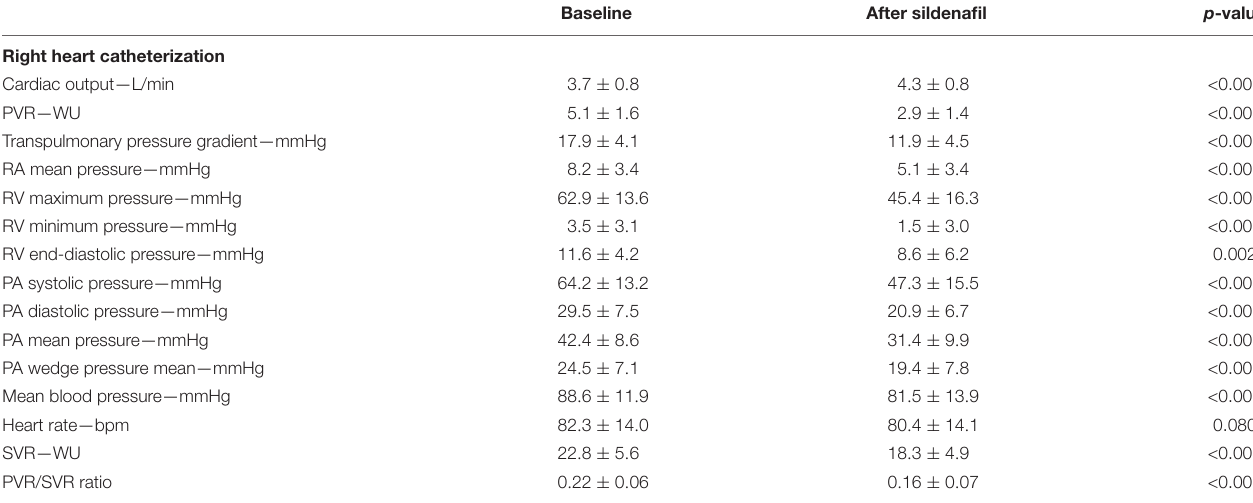
TABLE 2 | Effect of sildenafil on hemodynamic.